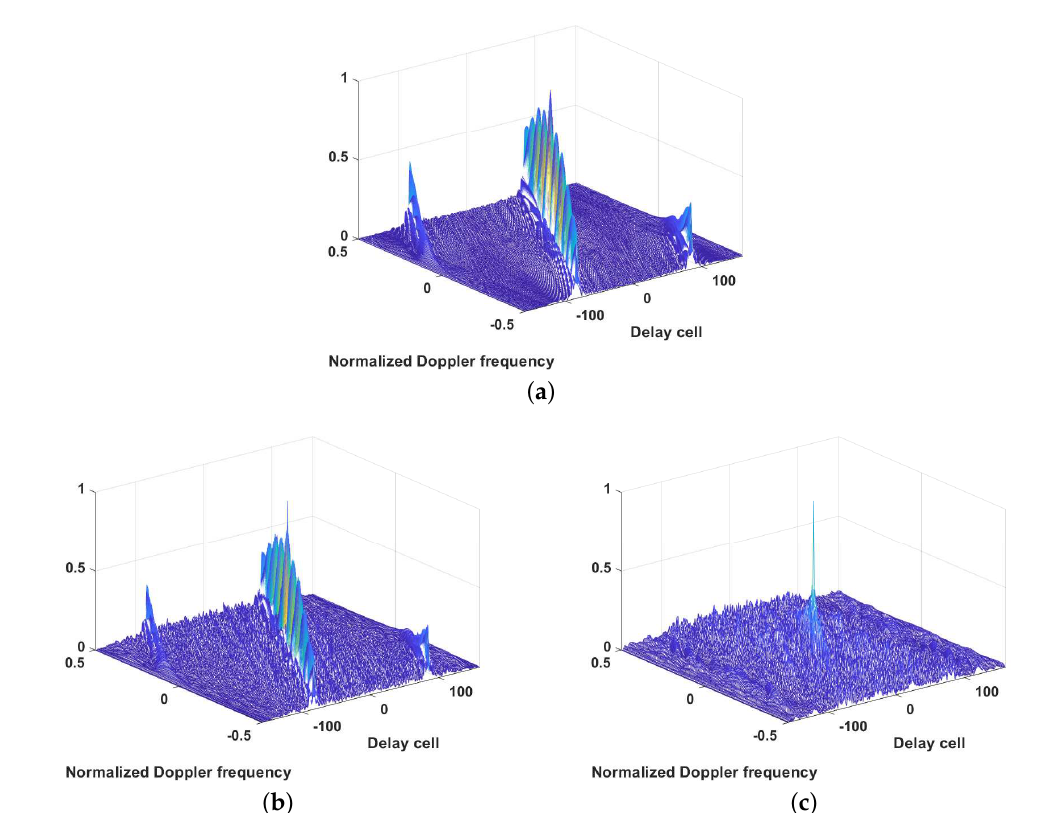
Figure 10. The AFs of the optimized AWs at − 30 ◦ . ( a ) The reference LFM. ( b ) The result from the proposed method. ( c ) The result from the